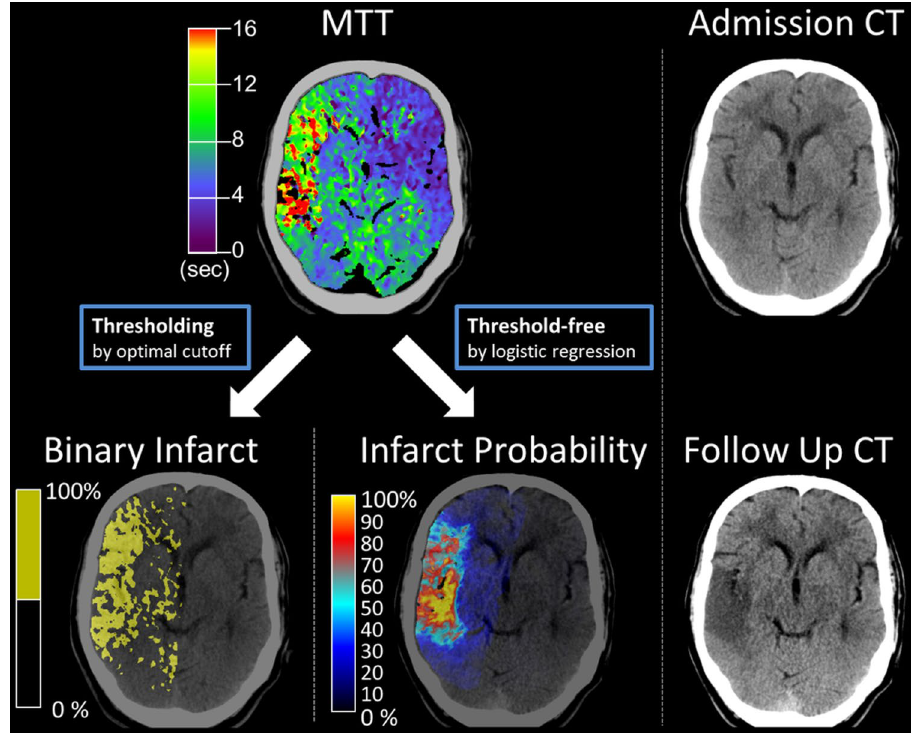
Figure 1. 161 acute stroke CTP maps were processed using traditional thresholding and the probability threshold-free method. Traditional thresholding generates a binary map of predicted infarction vs. no infarction. The threshold-free method uses logistic regression to generate a continuous voxel-wise map of infarct probability, and the sum of all infarct probabilities equals the predicted infarct volume. The infarct volumes predicted by both methods were compared to the real infarct volumes observed on follow up